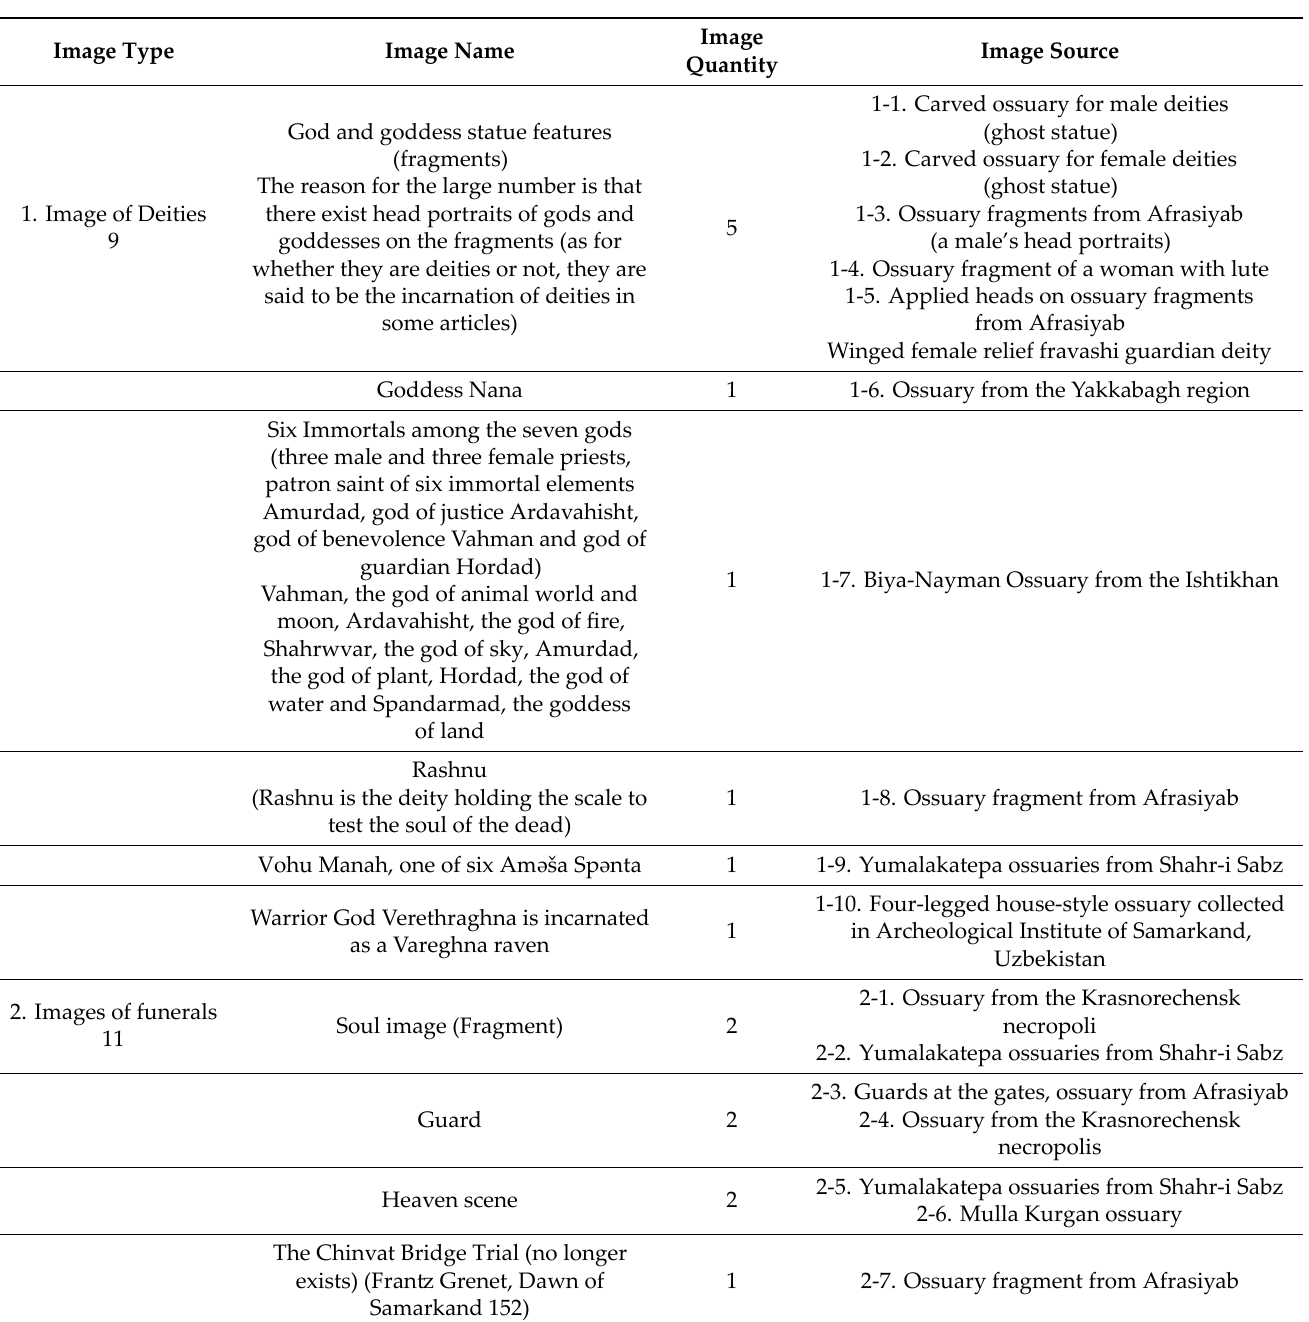
Table 5. Table of Religious Image Types for the Sogdian Ossuaries in Central